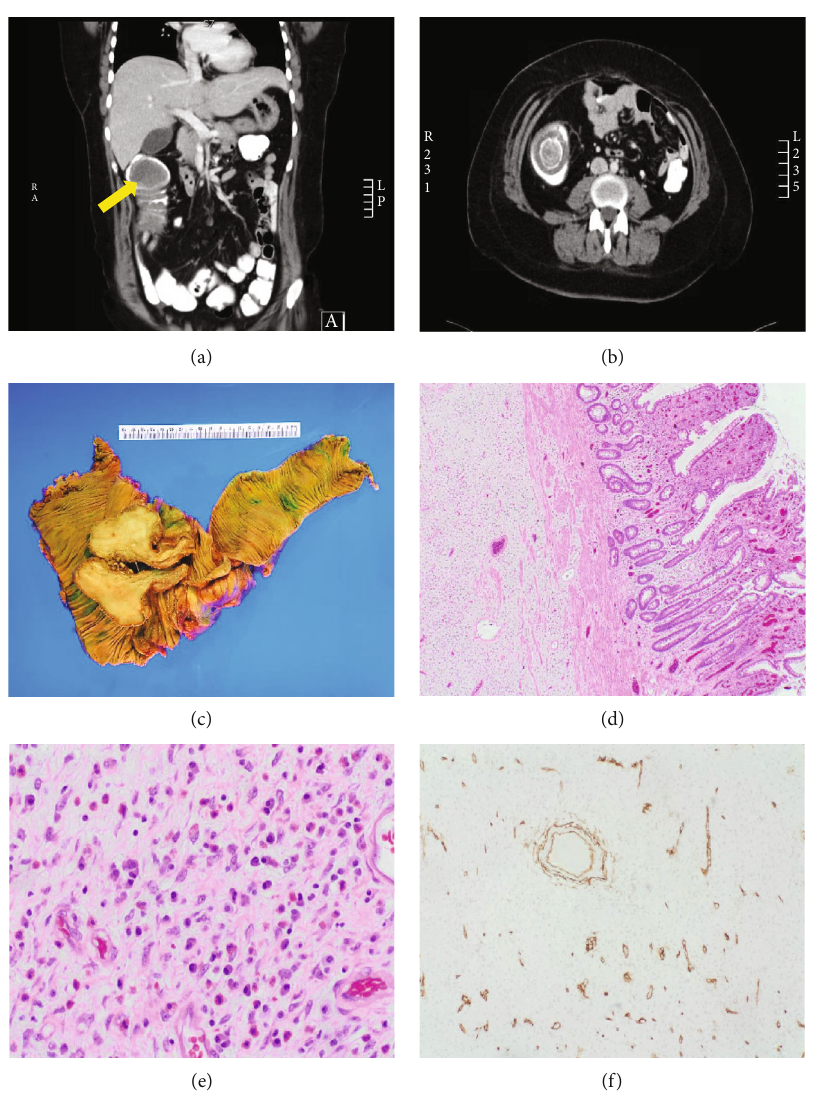
Figure 1: Representative hematoxylin and eosin (H&E) and immunohistochemical staining of in fl ammatory fi broid polyp (IFP). (a) Coronal (yellow arrow on mass). (b) Axial CT scan with contrast revealed ileocolonic intussusception measuring in maximum longitudinal axis about 7.4cm. (c) Gross examination revealed a large pedunculated polypoid mass measuring 7.5cm with attached stalk measuring 5 cm, located at the ileocecal valve. (d) Submucosal mass characterized by spindle cells embedded in a loose myxoid matrix (H&E; 2x). (e) Heavy in fl ammatory in fi ltrate with eosinophils and mast cells are observed (H&E; 20x). (f) CD34 expressed prominently in blood vessels, while tumor cells were negative